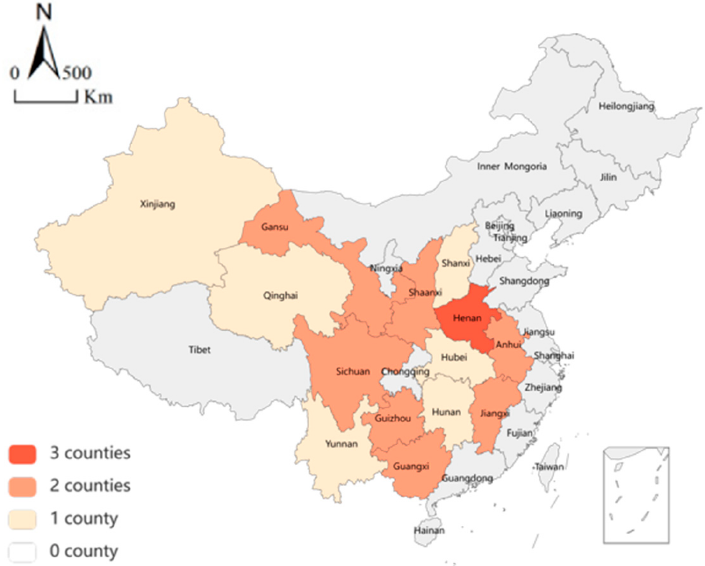
Figure 3. Distribution of sample poor counties.